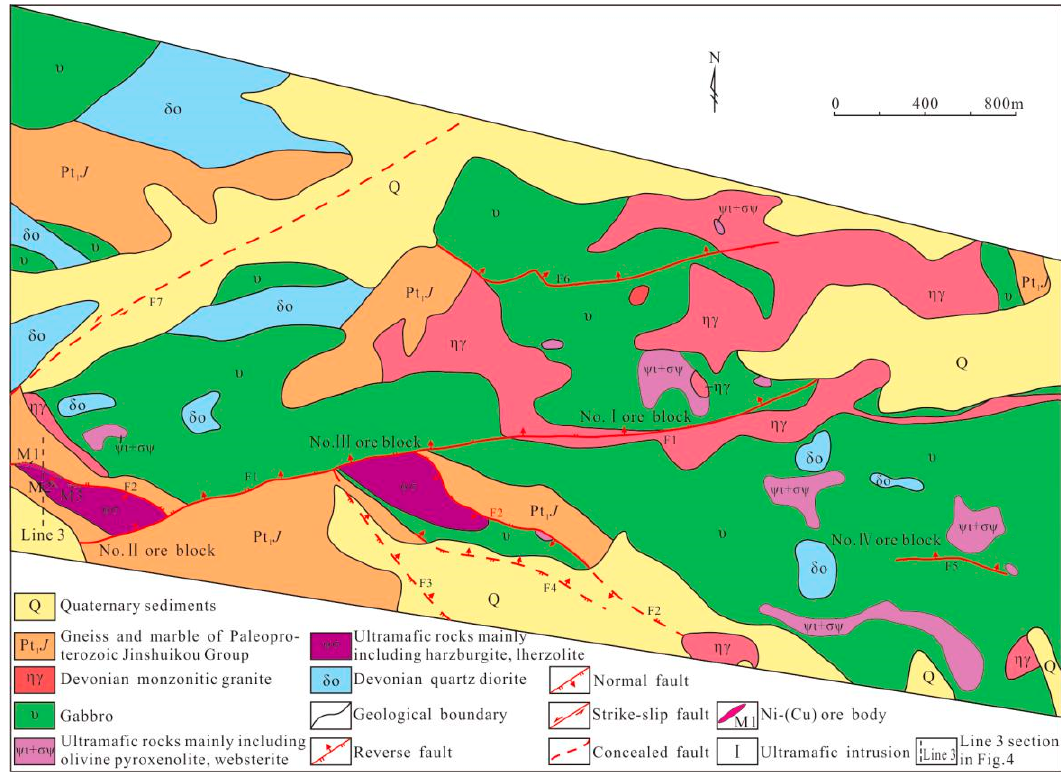
Figure 2. Geological map of the Niubiziliang Ni-(Cu) deposit (modified after Zhao et al. (2012a) [11]).